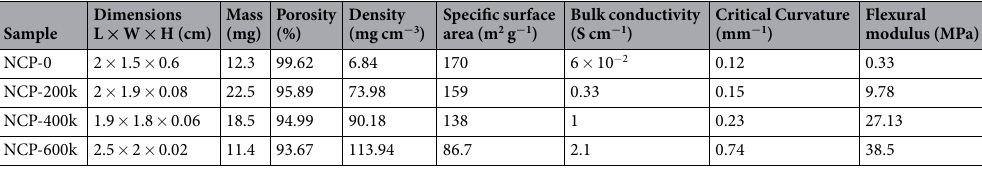
Table 1. Particulars of the synthesized NCP